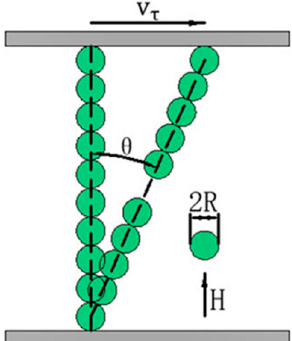
Figure 2. Shear deformation of a single chain.